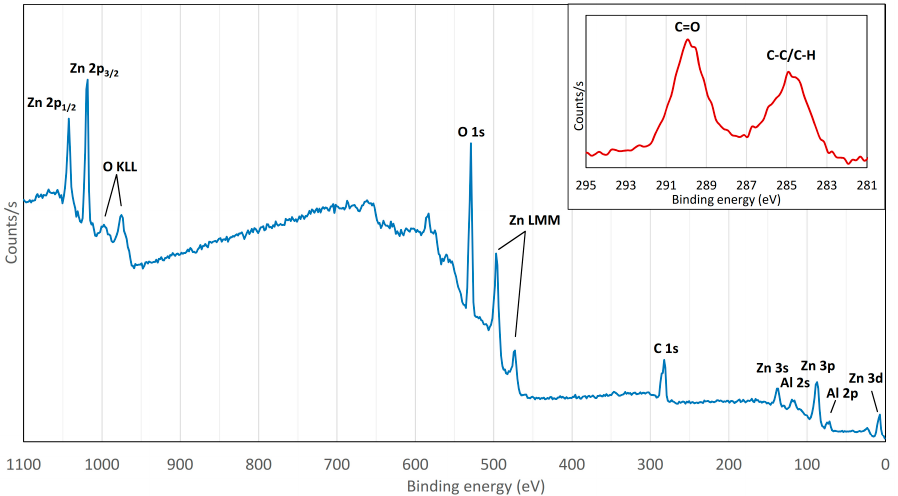
Figure 3. XPS survey spectrum of the scCO 2 -treated sample surface. The spectrum of the C 1s peak is presented in the insert after the sample had gone through mild sputtering.